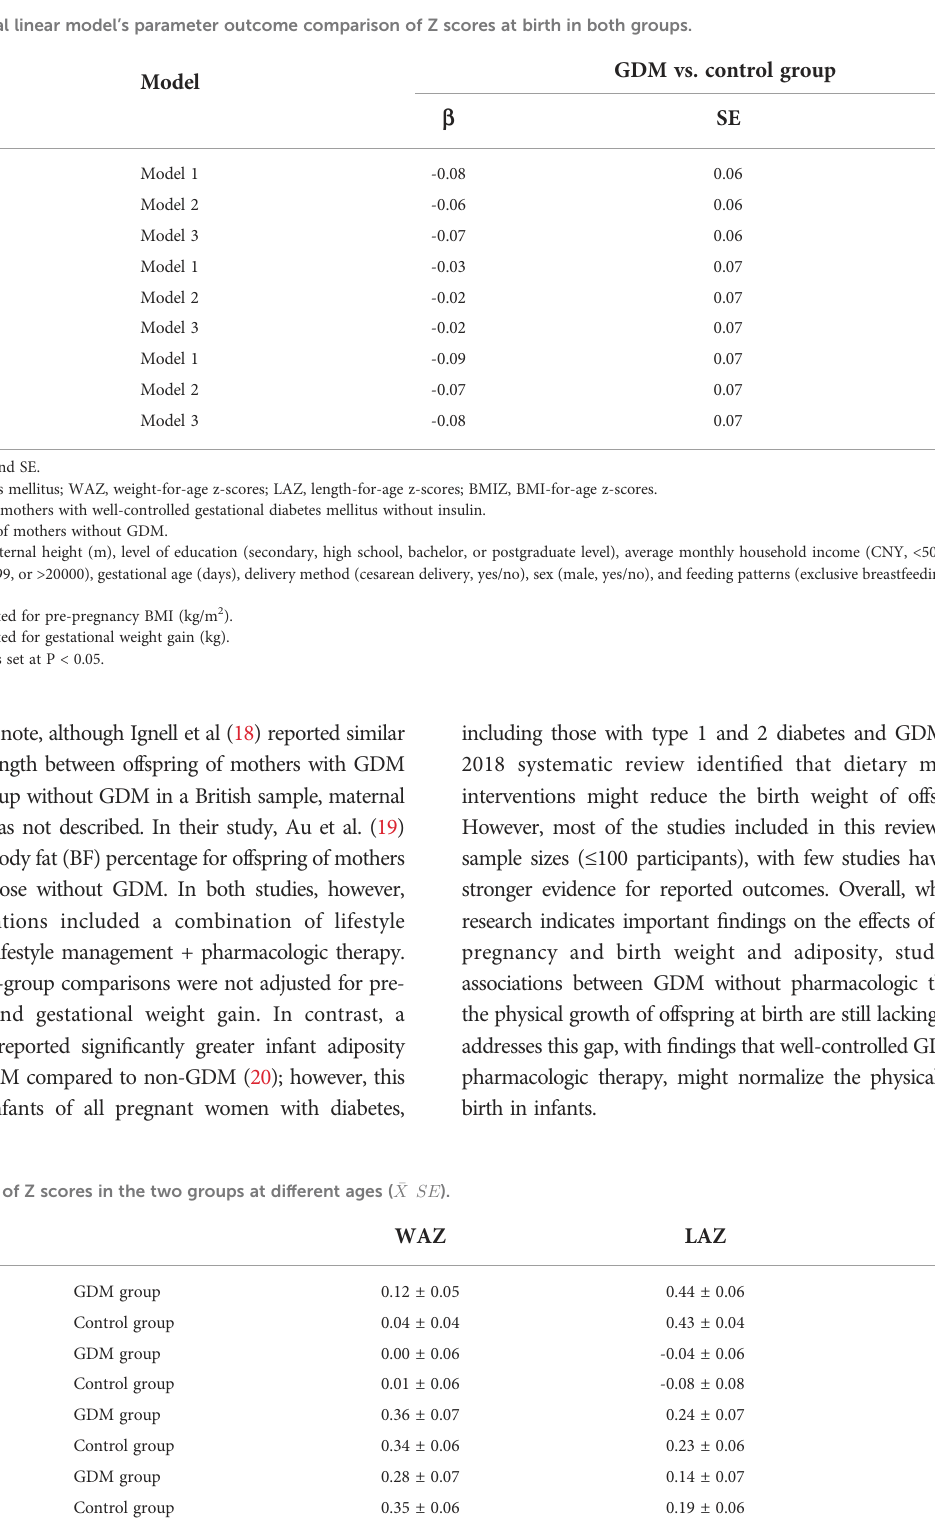
GDM, gestational diabetes mellitus; WAZ, weight-for-age z-scores; LAZ, length-for-age z-scores; BMIZ, BMI-for-age z-scores. GDM group: offspring of mothers with well-controlled gestational diabetes mellitus without insulin. Control group: offspring of mothers without